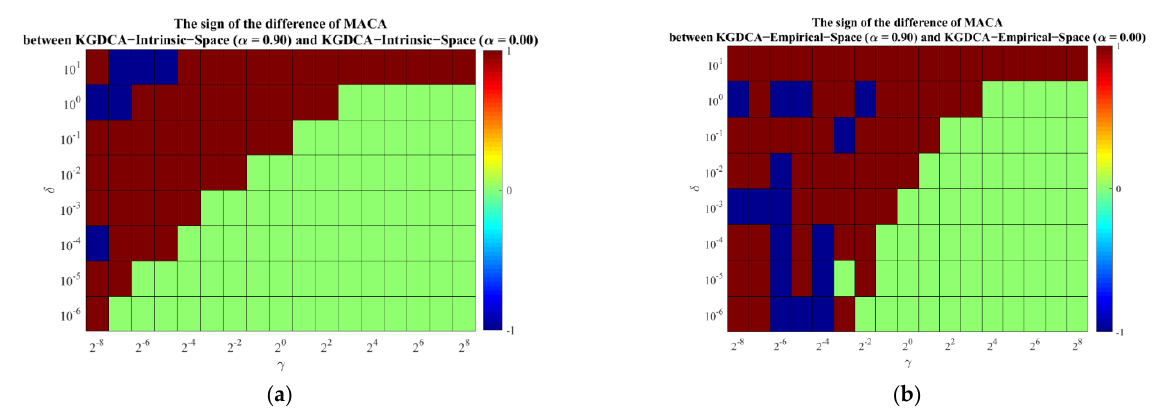
Figure 15. The sign of the difference of MACA between KGDCA − Intrinsic − Space/KGDCA − Empirical − Space ( α = 0.9) driven SVM and KGDCA − Intrinsic − Space/KGDCA − Empirical − Space ( α = 0) driven SVM under different values of γ and δ . ( a ) KGDCA − Intrinsic − Space driven SVM; ( b ) KGDCA − Empirical − Space driven SVM.